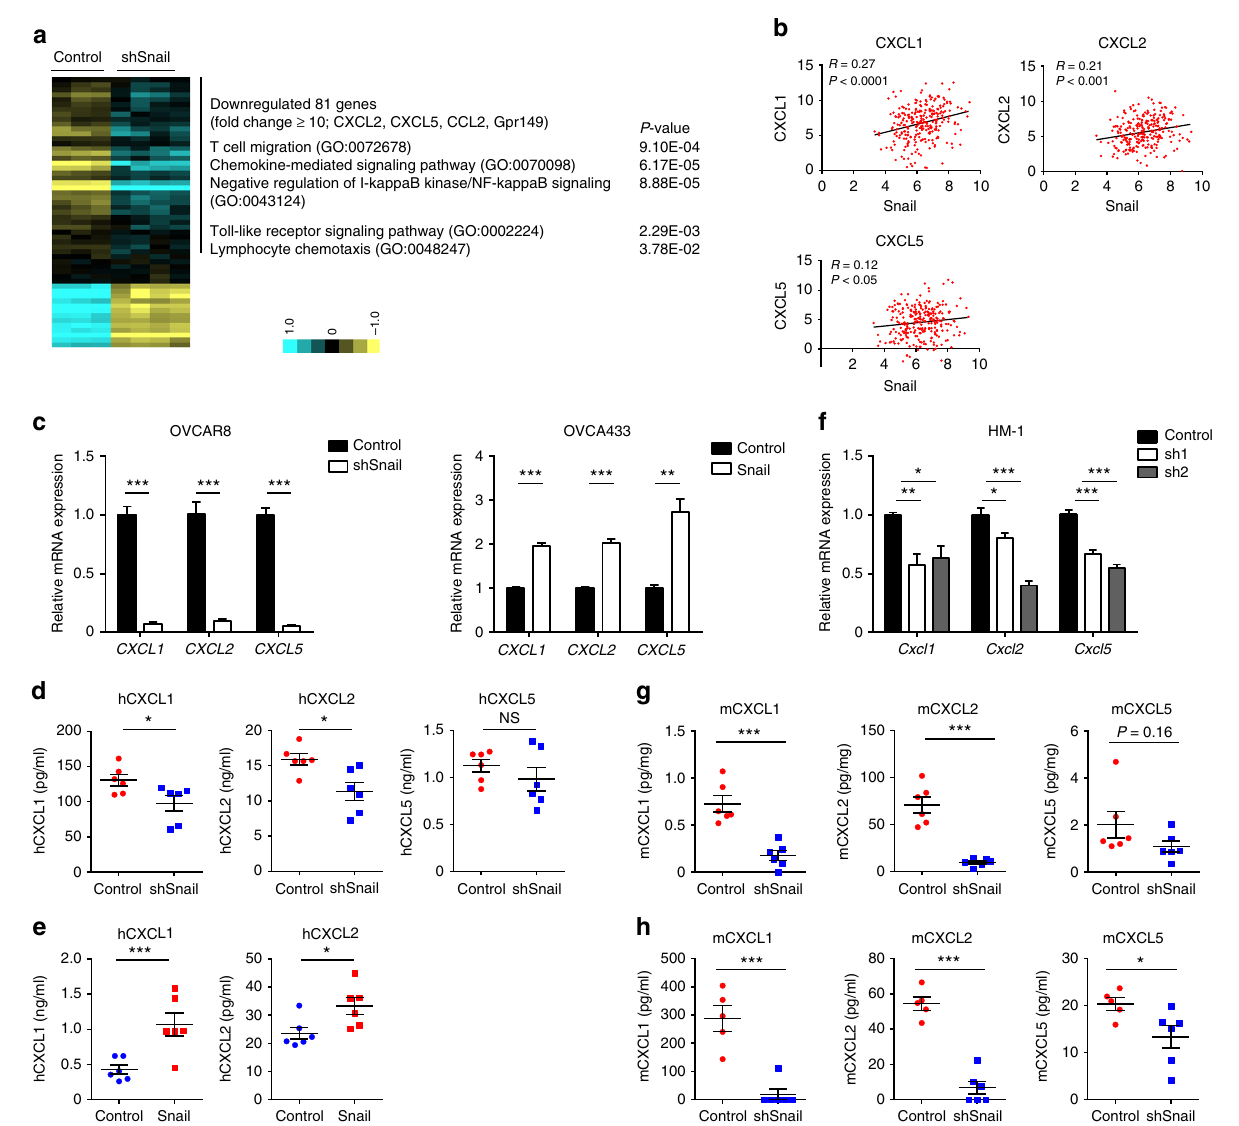
Fig. 4 CXCR2 ligands are highly expressed in Snail-high ovarian tumors. a GO (Gene Ontology) term analysis of DNA microarray data obtained from HM-1- control ( n = 3) and HM-1-shSnail (sh1; n = 2 and sh2; n = 2) cells. Genes that were signi fi cantly downregulated were used for GO term analysis. Genes are listed in Supplementary Table 2. b Snail expression was correlated with the expression of CXCR2 ligands (CXCL1; upper left, P < 0.0001, CXCL2; upper right, P < 0.001, and CXCL5; lower left, P < 0.05) in TCGA samples ( n = 266). Pearson ’ s product-moment correlation analysis. c Reverse transcription polymerase chain reaction (RT-PCR) of human ovarian cancer cell lines, OVCAR8 and OVCAR8-shSnail (left), and OVCA433 and OVCA433-Snail (right); n = 4. d , e ELISA of cell supernatants of human ovarian cancer cell lines, d OVCAR8 and OVCAR8-shSnail, and e OVCA433 and OVCA433-Snail; n = 6. f RT-PCR of HM-1-control and HM-1-shSnail cells; n = 5. g , h Levels of CXCL1, CXCL2, and CXCL5 in subcutaneous tumors ( g ) and in blood ( h ) taken from mice bearing HM-1-control and HM-1-shSnail tumors; n = 6. * P < 0.05, ** P < 0.01, and *** P < 0.001 (unpaired t -test in c – e , g , h ; one-way ANOVA with Tukey ’ s multiple comparisons test in f ). Averaged data are presented as the mean ±